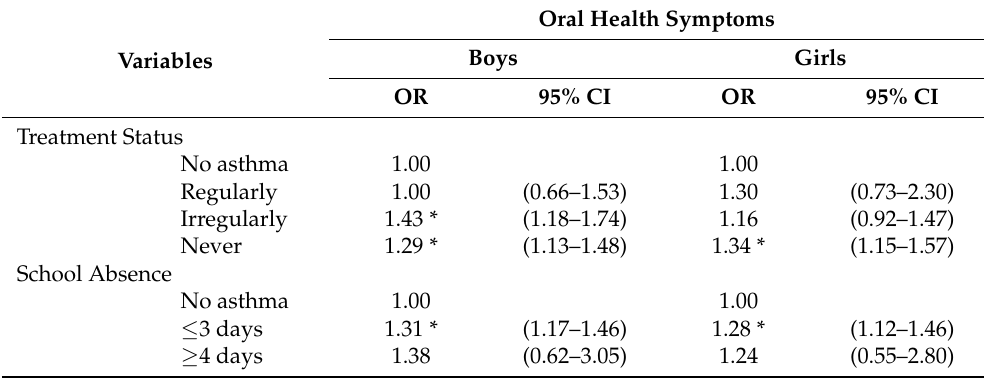
Table 4. Results of subgroup analysis stratified by the severity of asthma.